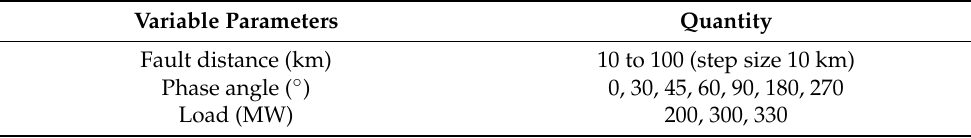
Table 2. Variable parameters set up in the simulation